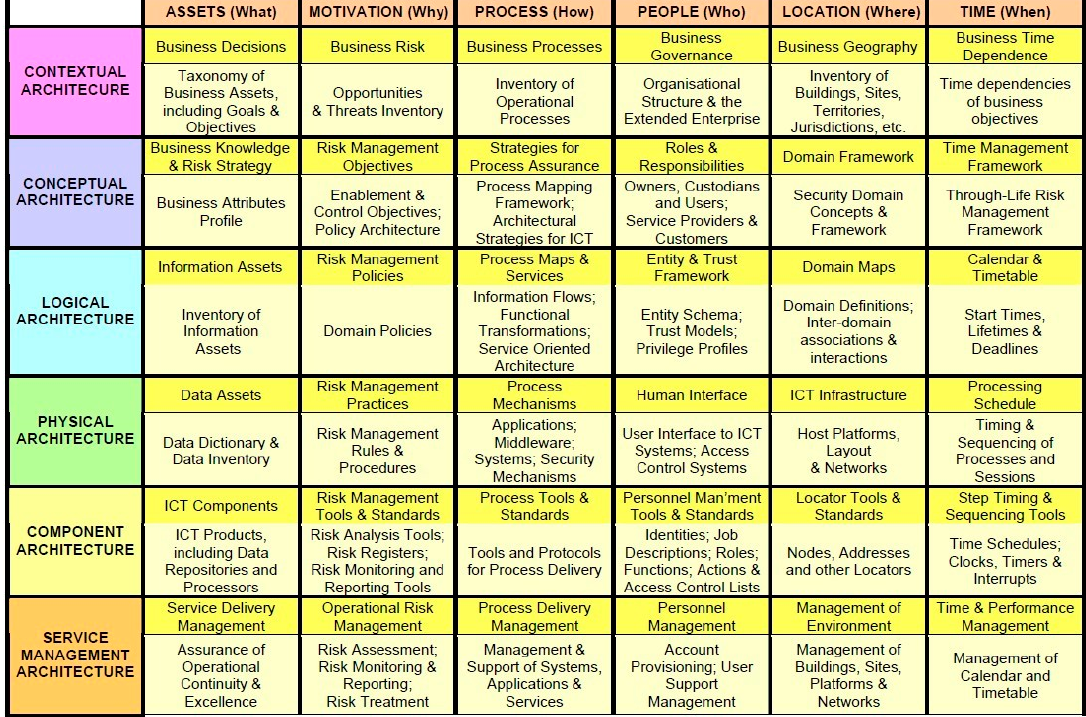
Figure 11. The SABSA matrix (https://sabsa.org/—@2019 The SABSA Institute C.I.C).